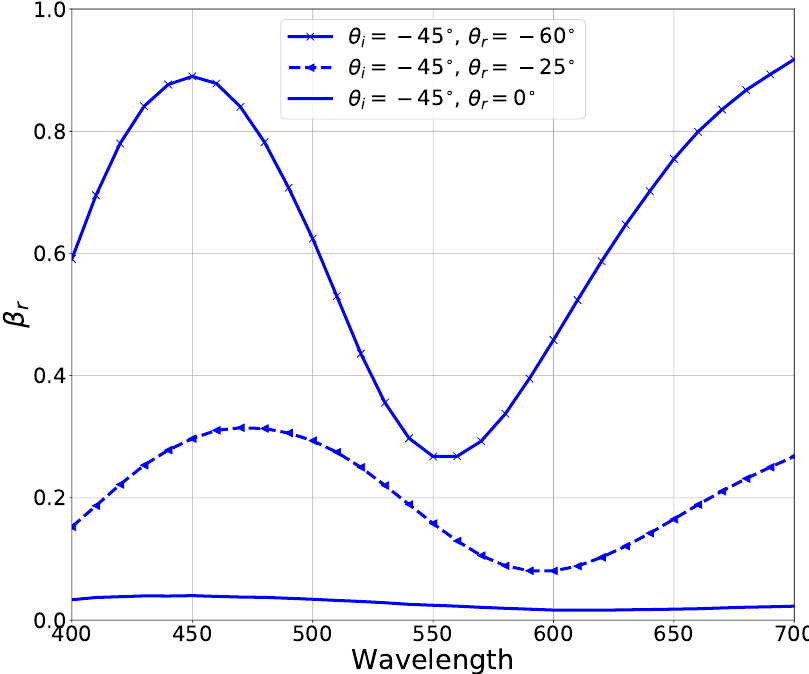
Figure 1. Color shift obtained from the spectral radiance factor measurements of the Blue-Green sample surface using the GCMSinstrument at θ i = − 45 ◦ and θ r = − 65 ◦ , − 25 ◦ and 0 ◦ . Please note: f r can be further calculated using the f r = β r relation [26]. π